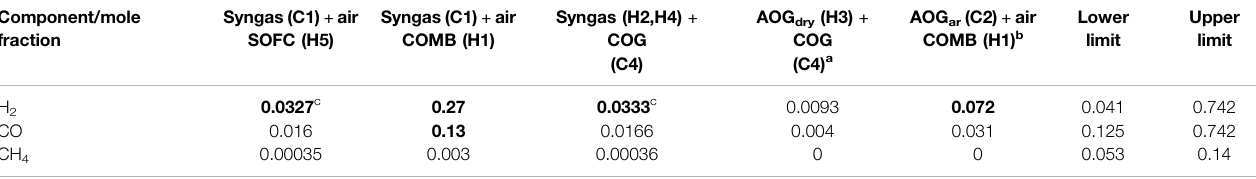
TABLE 8 | Combustible and oxygen-rich stream mixtures, compared to the upper and lower fl ammability limits in air (Towler and Sinnott, 2013). Component/mole